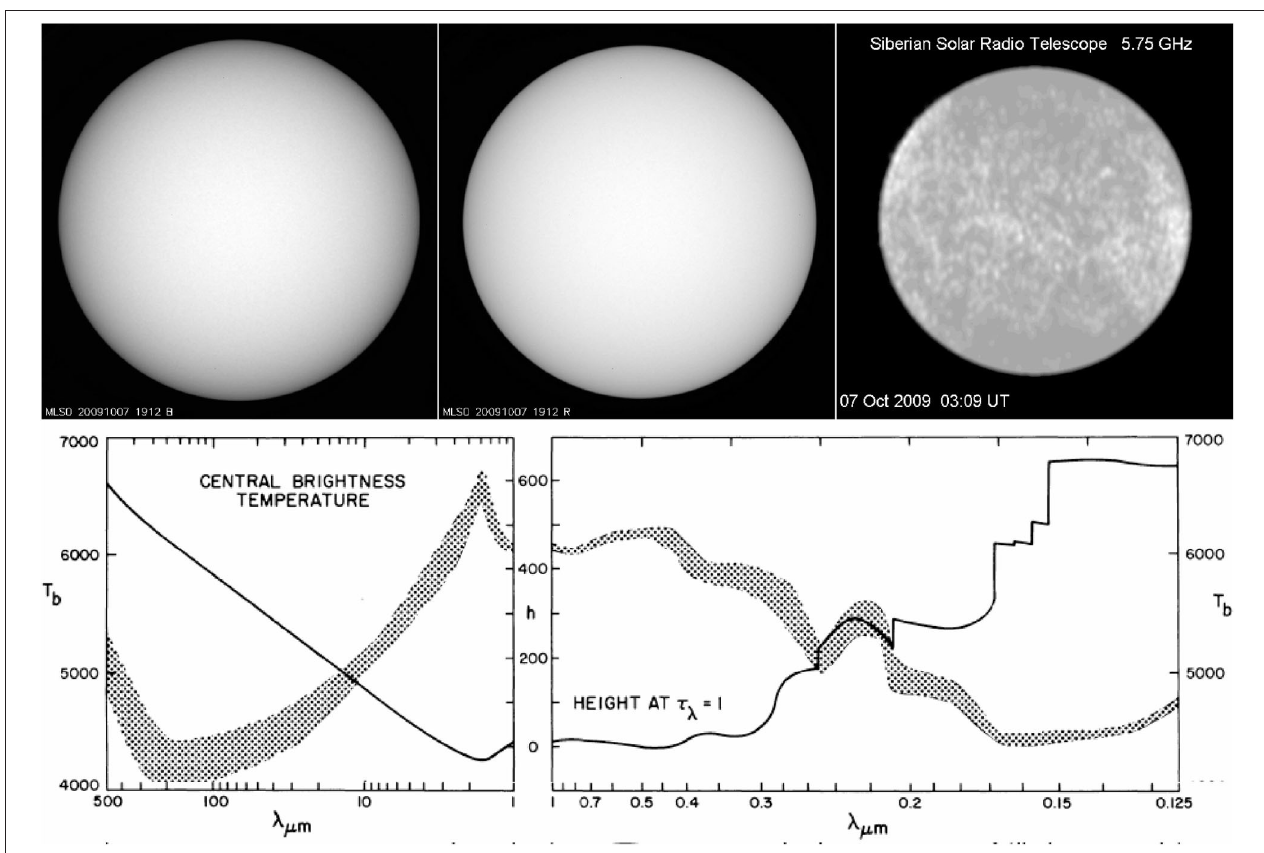
FIGURE 1 | (Top) Solar images on October 7, 2009 in the blue part of the spectrum (left) in the red (middle) from the Mauna Loa Solar Observatory (MLSO) and at λ 5.2cm from the Siberian Solar Radio Telescope (SSRT); images selected by the author. (Bottom) Observed continuum brightness temperature at the center of = the solar disk as a function of wavelength (shaded band) and the approximate height of formation of the radiation (black line); from Vernazza et al. (1976), © AAS, reproduced with